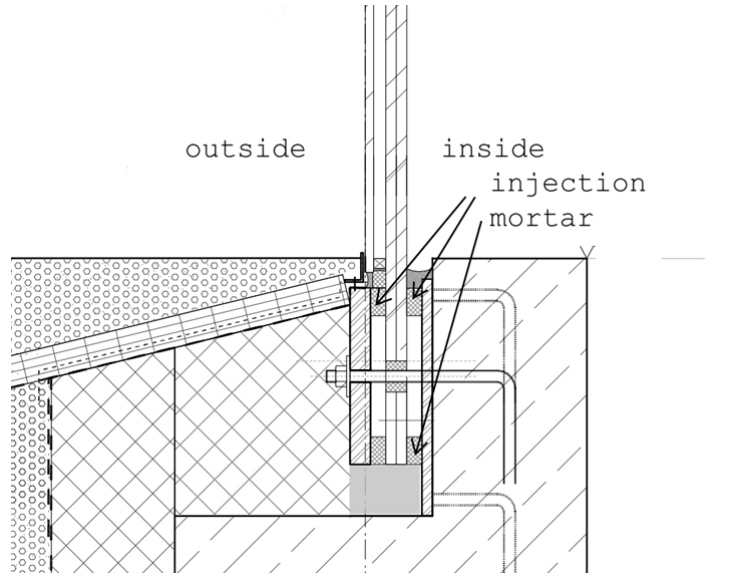
Fig. 12 Detail of the floor connection at the